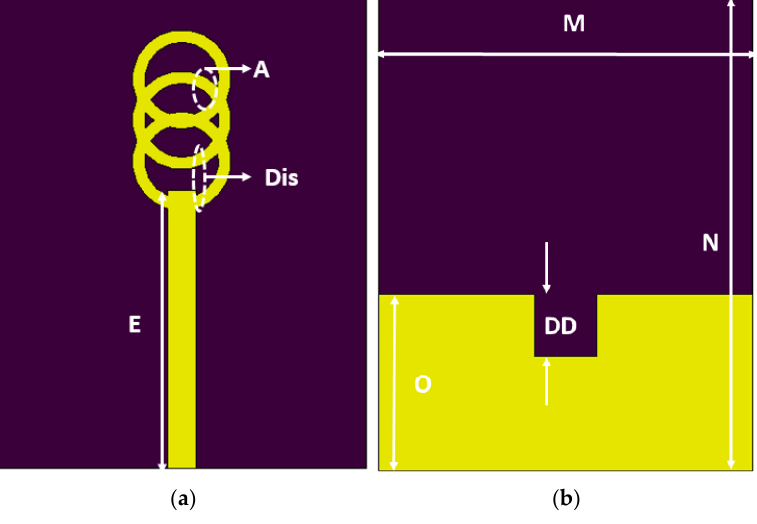
Figure 1. ( a ) Front ( b ) back views of the proposed antenna. As observed in Figure 2a, the parameter DD has a significant impact on the resonance apart value. As shown, at 0.8 mm, the antenna showed resonance from 27 to 42.6 GHz, while for 0.9 mm, the bandwidth ranged from 26.7 to 42.0 GHz. The optimum response was attained at a 1 mm ground slot value, exhibiting bandwidth characteristics from 26 to 41 GHz. It was observed that the ground slot affects higher frequency. In addition, the reflection coefficient response overall moves to lower values. Next, the parametric re- sponse concerning the distance between the circular loops is analyzed. The distance im- pact is analyzed at a 0.1 mm value. As observed in Figure 2b, the lower frequency range is affected by the starting values of 0.65 and 0.7 mm. The optimum response was achieved at 0.75 mm, as after this value, the reflection coefficient response is degraded. Figure 2c shows the feed line modeling effect for the proposed structure. As observed in Figure 2c, at the initial value of 6.55 mm, the resonance response stretches up to 42 GHz but the starting frequency response also moves forward. With the gradual increase of 0.05 mm, the resonance response moved backwards and the optimum response was achieved at 6.75 mm. Figure 2d shows the single element reflection coefficient obtained.